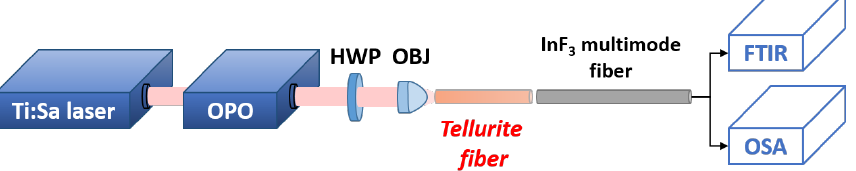
Figure 10. Experimental set-up used for mid-IR supercontinuum generation. OPO: optical parametric oscillator. HWP: half-wave plate. OBJ: 20 × microscope objective lens. FTIR: Fourier-transform infrared spectrometer. OSA: optical spectrum analyzer.